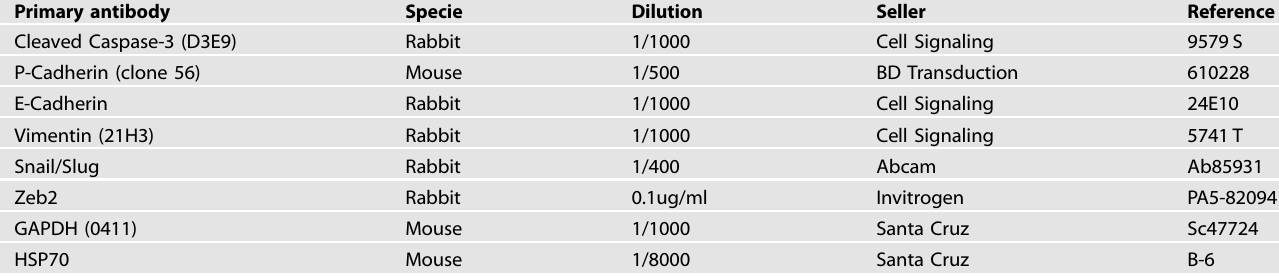
Table 1. Western Blot primary antibodies.